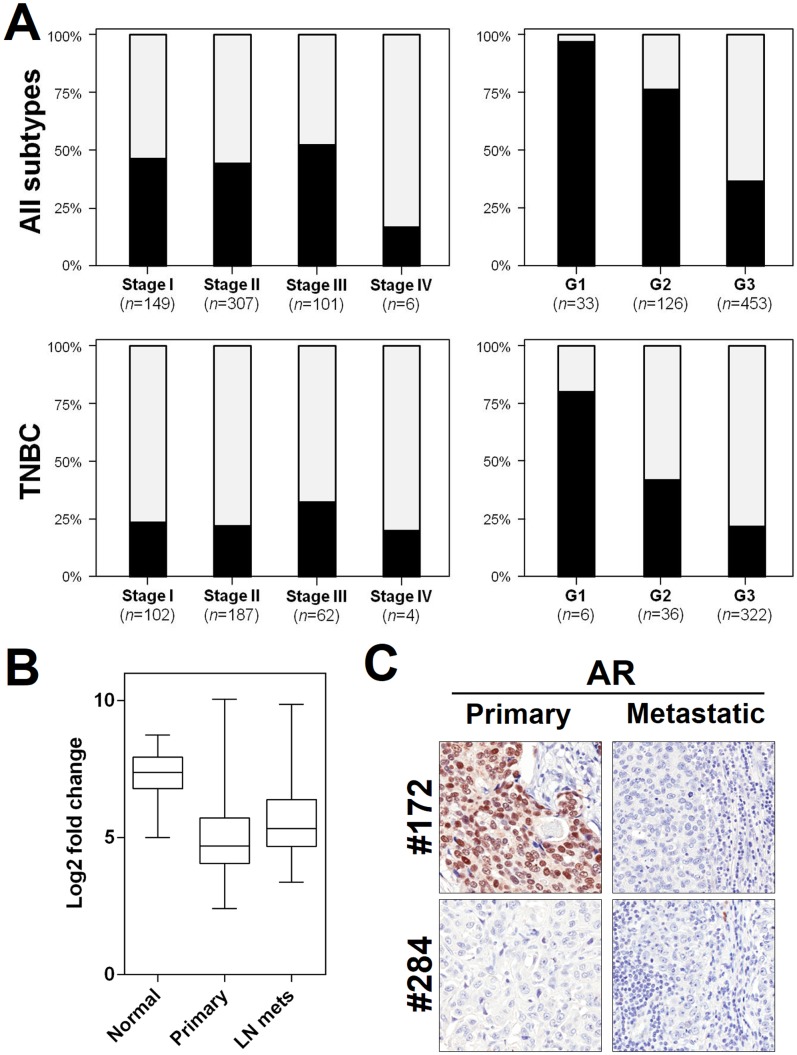
Androgen receptor status is associated with tumor grade and is consistent among primary and secondary lesions.AR expression distribution according to tumor stage and grade (A). AR was lower in high grade tumors in both the whole series and in the TNBC subgroup (p<0.01 both), but was consistently distributed among the different tumor stages. Black  =  AR positive cases, gray  =  AR negative cases. (B) AR mRNA expression is down-regulated in TNBC primary tumors and lymph node metastases. (C) Representative images of AR immunostaining in two matched primary tumors and lymph node metastases. Case #172 showed a positive primary neoplasm and a negative metastatic lesion. Case #284 is AR negative in both neoplastic lesions. (Original magnification, 200×)